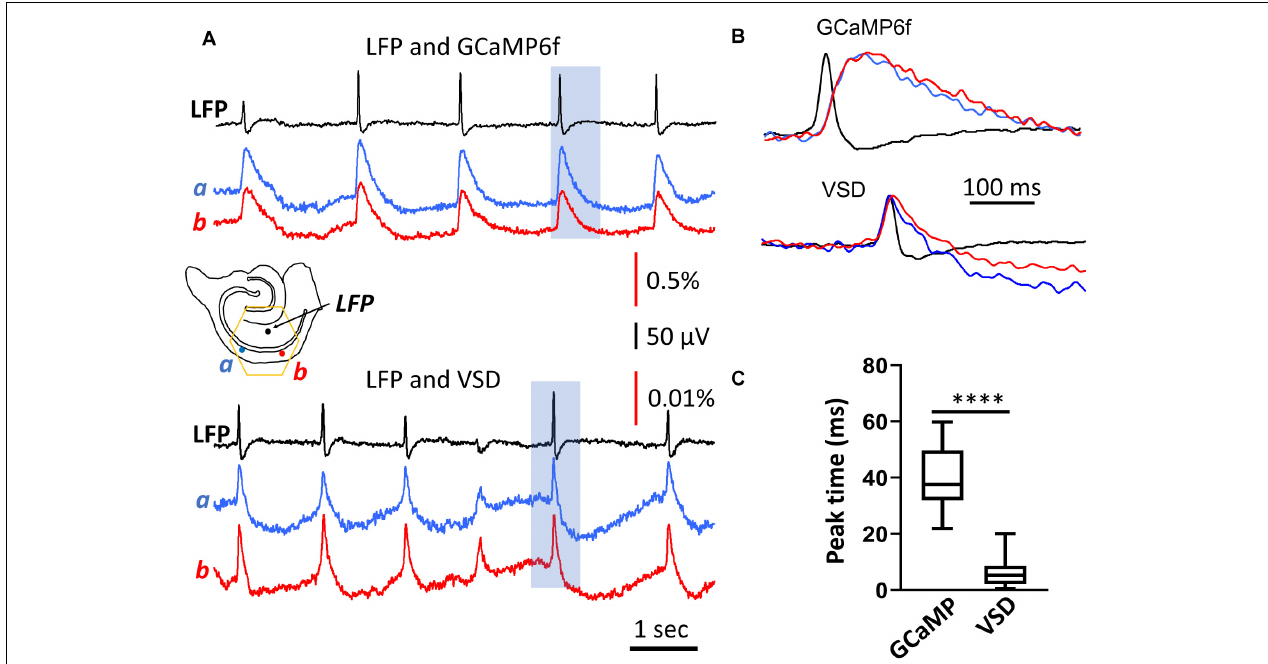
FIGURE 2 | Rise time of the population GCaMP6f signal. (A) LFP and GCaMP/VSD recordings of SWs in the same tissue. LFP (black trace, filtered 0.2–50 Hz) were highly correlated with events detected optically at two different CA1 locations either with GCaMP6f (blue and red traces, top, filtered 0.2–50 Hz) or VSD (blue and red traces, top, filtered 0.2–50 Hz). Note the different y-scale for GCaMP and VSD traces, GCaMP events were about 50 times larger and slower. Black arrows mark the SWs displayed in expanded time scale in panel (B) GCaMP signals showed a marked delay compared to the LFP, which was not observed in the VSD signals from the same tissue. (C) Box and whisker plots of the peak delay time between LFP and optical signals. As expected, GCaMP signals showed a longer delay time of 40.3 ms (SD 10.8 ms, n = 84 SWs, in two slices from two animals) compared to VSD delay time of 5.7 ms (SD 4.1 ms, n = 82 SWs from same slices), a significant difference of p < 0.0001